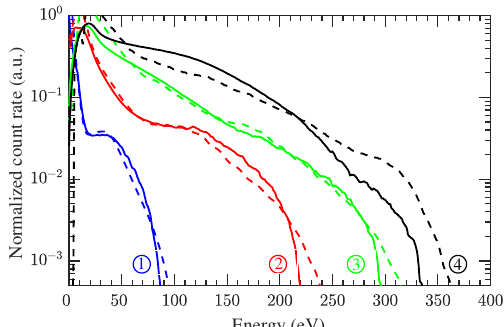
Figure 3. (color online) Simulated energy-resolved photoelectron spectra in the near-field of a nanotip for different wavelengths, keeping the other laser parameters fixed (see text for more details). The spectra from the same wavelength are scaled along the y-axis to match the mid energy region with each other. All the spectra are averaged, both over different CEPs and the focal spot. The numbers 1–4 correspond to the wavelengths λ = 800nm, 1600nm, 2400nm and 3200nm, respectively. Solid lines: CTMC simulations, dashed lines: TDSE results.